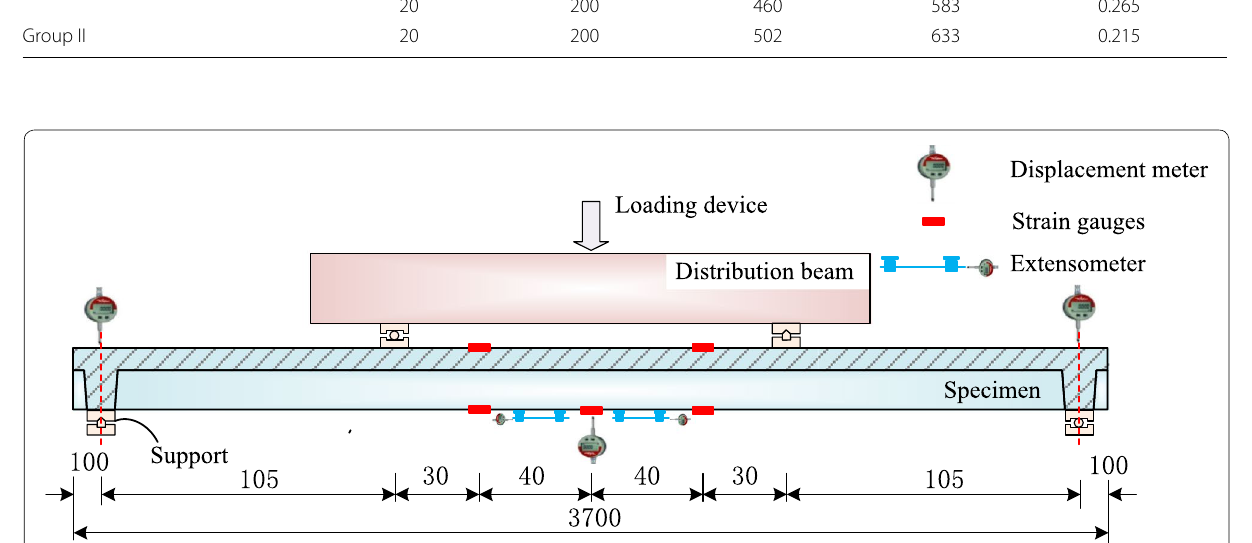
Fig. 8 Details of experimental program (unit: